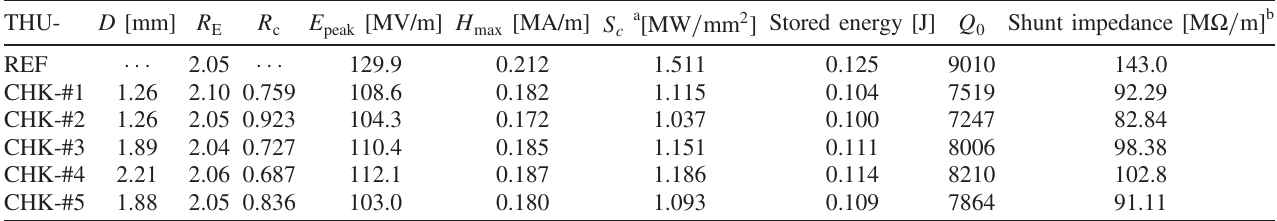
TABLE I. Information of the choke-mode structures.